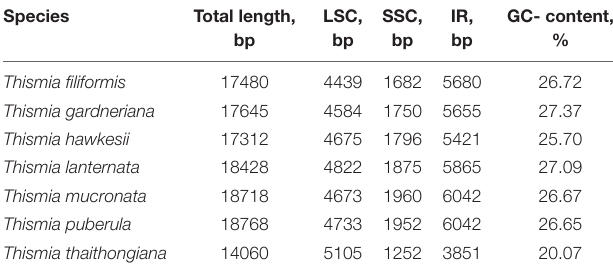
TABLE 1 | Characteristics of complete plastomes of Thismia